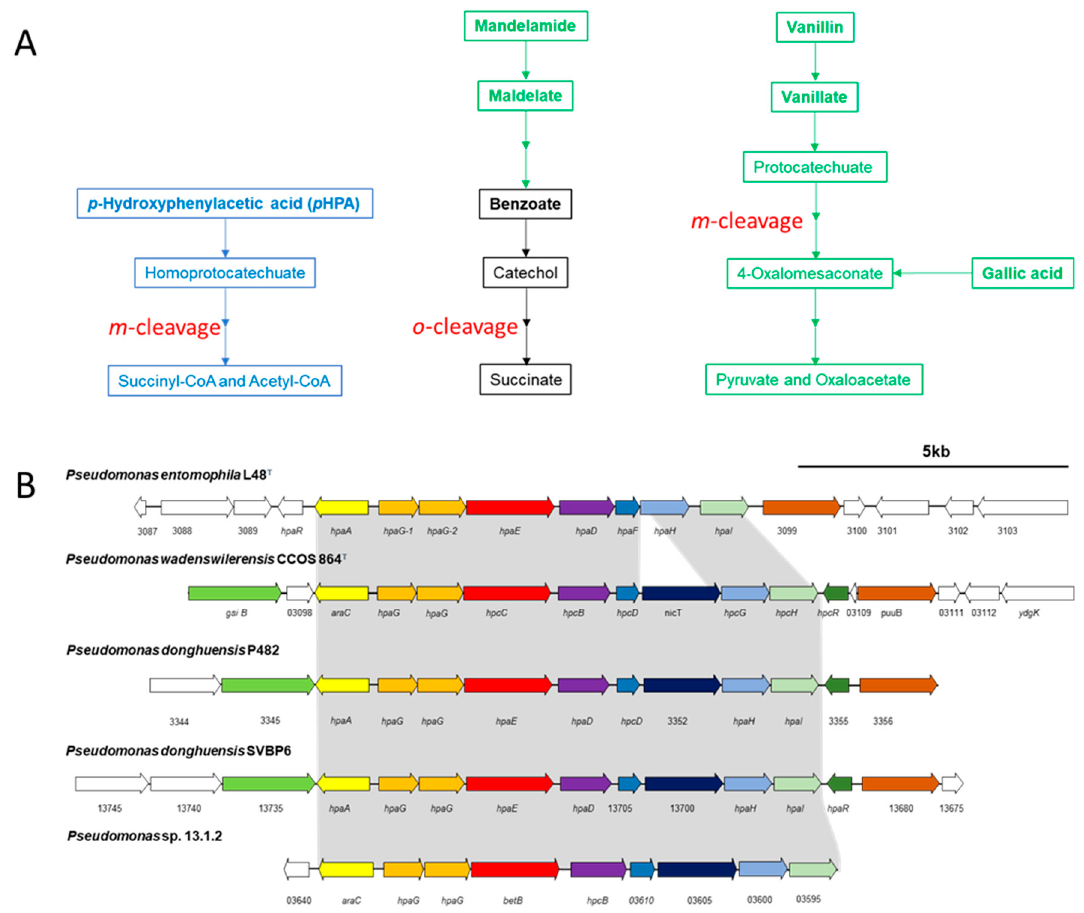
Figure 3. ( A ) Schematic degradation pathways for aromatic compounds in Pseudomonas wadenswilerensis CCOS 864 T and Pseudomonas reidholzensis CCOS 865 T . Colors represent the organisms in which they are found: blue: only P. wadenswilerensis CCOS 864 T ; green: only P. reidholzensis CCOS 865 T , black: both species. ( B ) Gene cluster for p ‐ hydroxyphenylic acid ( p ‐ HPA) degradation. Orthologous genes are marked in the same color. The grey shading shows identical gene arrangements within the genomes.